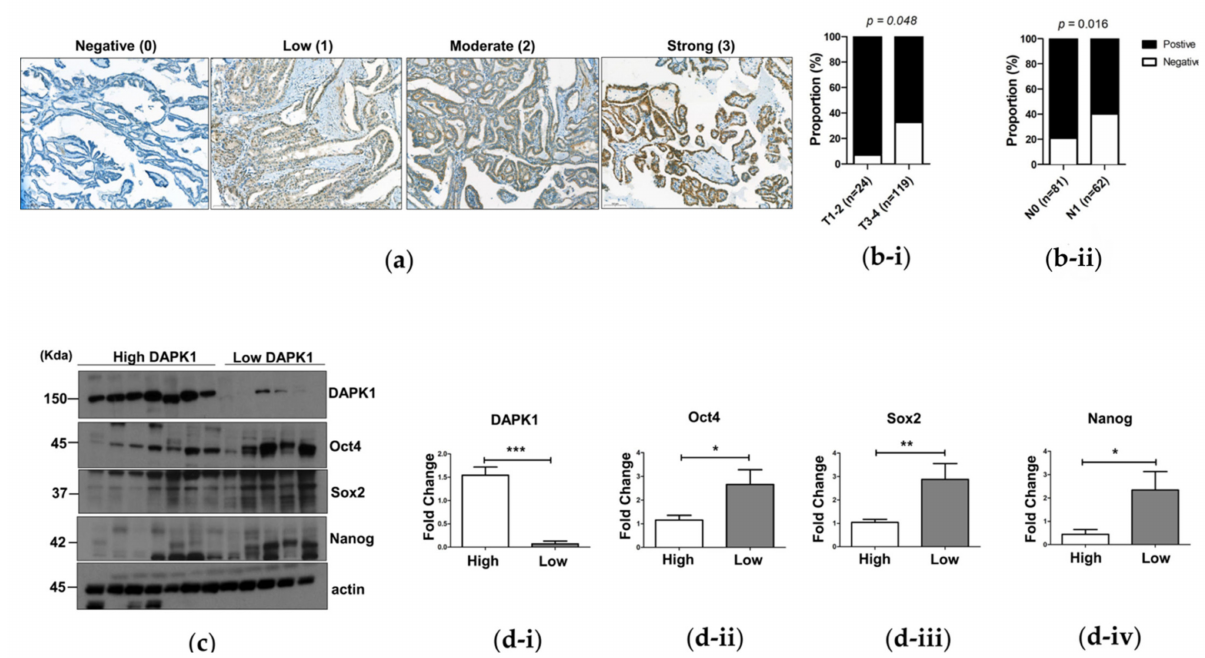
Figure 5. The relationship between DAPK1 and stem markers or pathological characteristics in thyroid cancer. ( a ) Representative images of IHC staining of DAPK1 in PTC tissues. The cytoplasmic staining intensity was semi- quantitatively graded as negative (0), low (1), moderate (2), or strong (3). We regarded the DAPK1 expression as positive when the tissues showed 1 or more staining intensities. ( b ) The relationship between DAPK1 expression and pathological characteristics of PTC. ( b-i ) Comparison of the DAPK1 expression between T1-T2 ( n = 24) and T3-T4 ( n = 119) tissues by the two-tailed Student’s t -test. The proportion of DAPK1 positivity was significantly lower in T3-T4 tissues than T1-T2 tissues ( p = 0.048). ( b-ii ) Comparison of the DAPK1 expression between PTCs without LN metastasis (N0, n = 81) and with LN metastasis (N1, n = 62) by the two-tailed Student’s t -test. The proportion of DAPK1 positivity was significantly lower in PTCs with LN metastasis than in those without LN metastasis ( p = 0.016). ( c , d ) Western blot was performed to examine the expression of stem cell markers associated with the expression of DAPK1 in human tissue samples. We used 12 fresh-frozen PTC human thyroid tissues. Actin was used as a loading control. ( c ) Representative Western blot results. The expression of stem cell markers (Oct4, Sox2, and Nanog) according to the expression of DAPK1 protein in human PTC tissues was investigated. When the protein expression of DAPK1 was high, the protein expression of various stem cell markers (Oct4, Sox2, and Nanog) was low in PTC tissues, and when the expression of DAPK1 was low, the expression of stem cell markers was confirmed to have increased conversely. ( d ) Quantification of ( c ). ( d-i ) DAPK1. ( d-ii ) Oct4. ( d-iii ) Sox2. ( d-iv ) Nanog Asterisks ( p < 0.05 (*), p < 0.01 (**), p < 0.001 (***)) indicate significant differences in the statistical